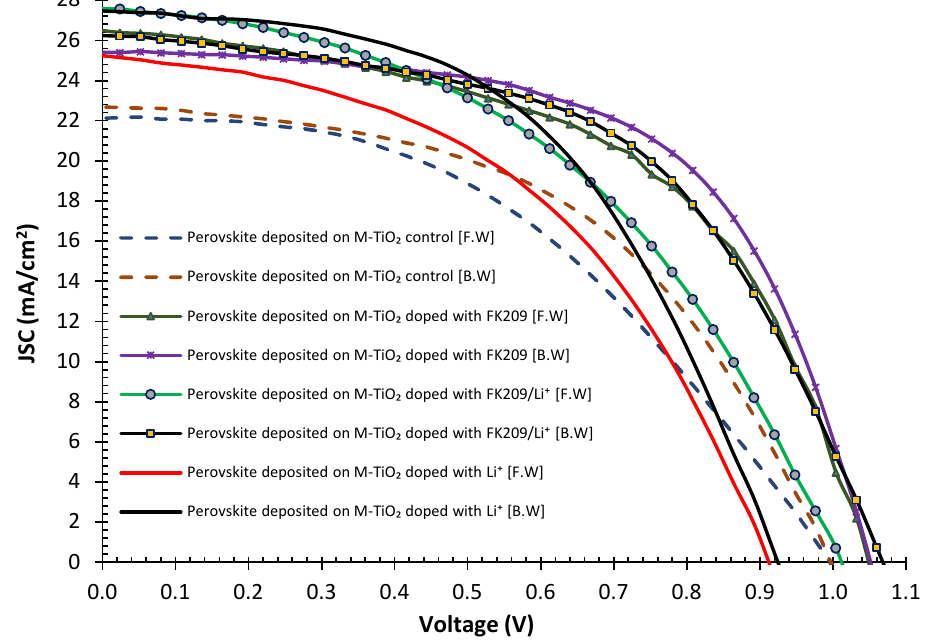
Figure 12. The illuminated J-V characteristic curves of perovskite solar cells deposited on ETL of M-TiO 2 doped with FK209, FK209/Li + and lithium.